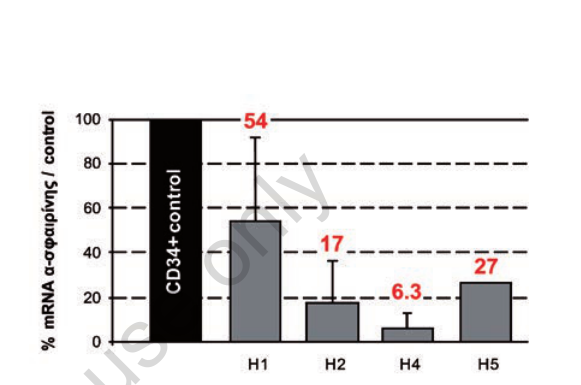
Figure 4. a -globin mRNA expression in mouse BFUe after trans- duction of Lin- cells with FV vectors expressing the relative anti- a -globin shRNA.